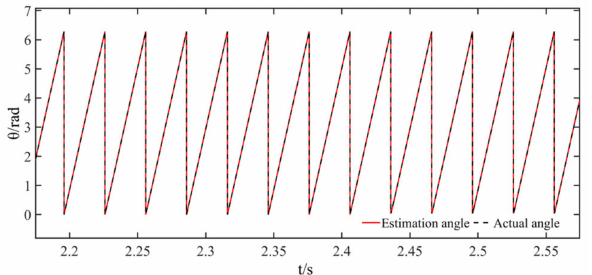
Figure 9. Speed waveforms comparison at 500 r/min.